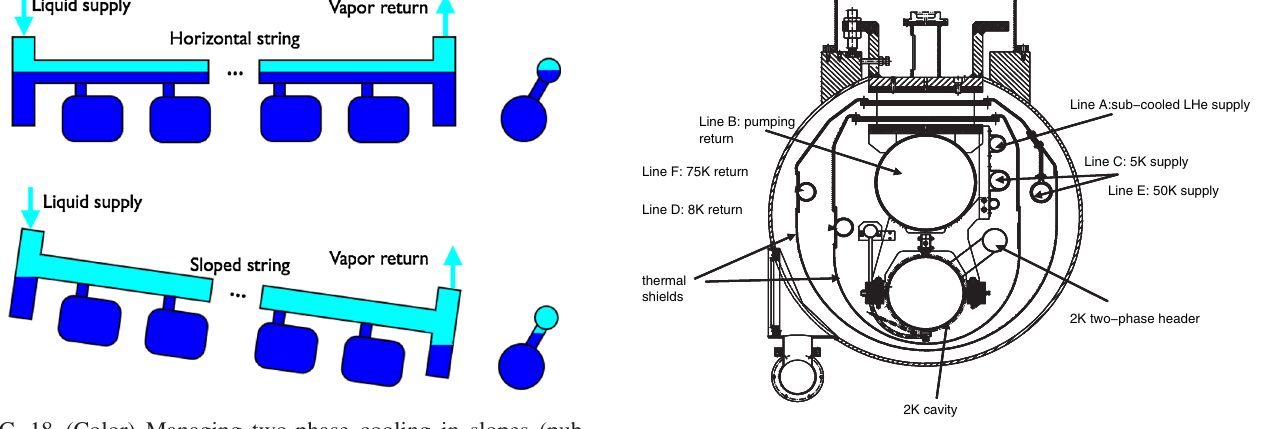
FIG. 18. (Color) Managing two-phase cooling in slopes (pub- lished in [44]).